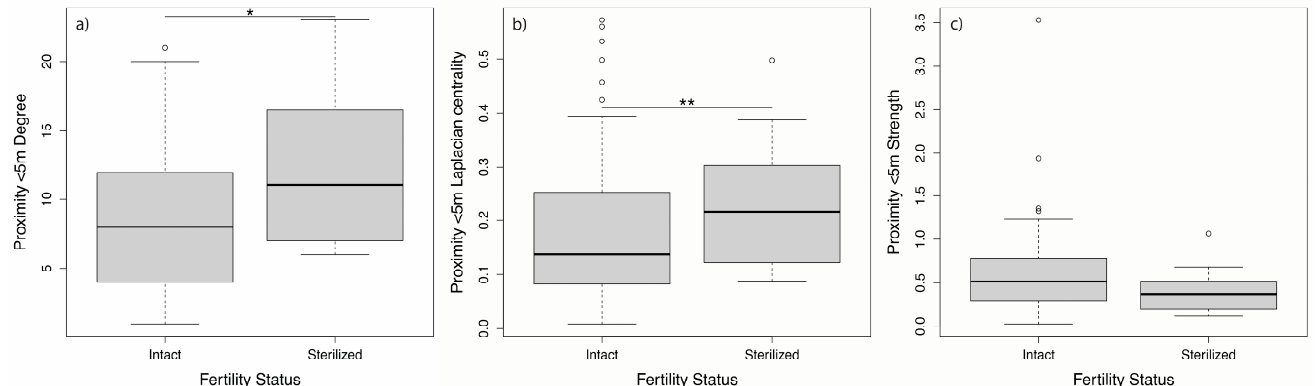
Figure 4. Comparison of the average (median) ( a ) Degree (number of female neighbors), ( b ) Laplacian centrality (connectivity power), and ( c ) Strength (frequencies of association) between sterilized and intact females for the 5 m proximity network (* p < 0.05, ** p < 0.01).